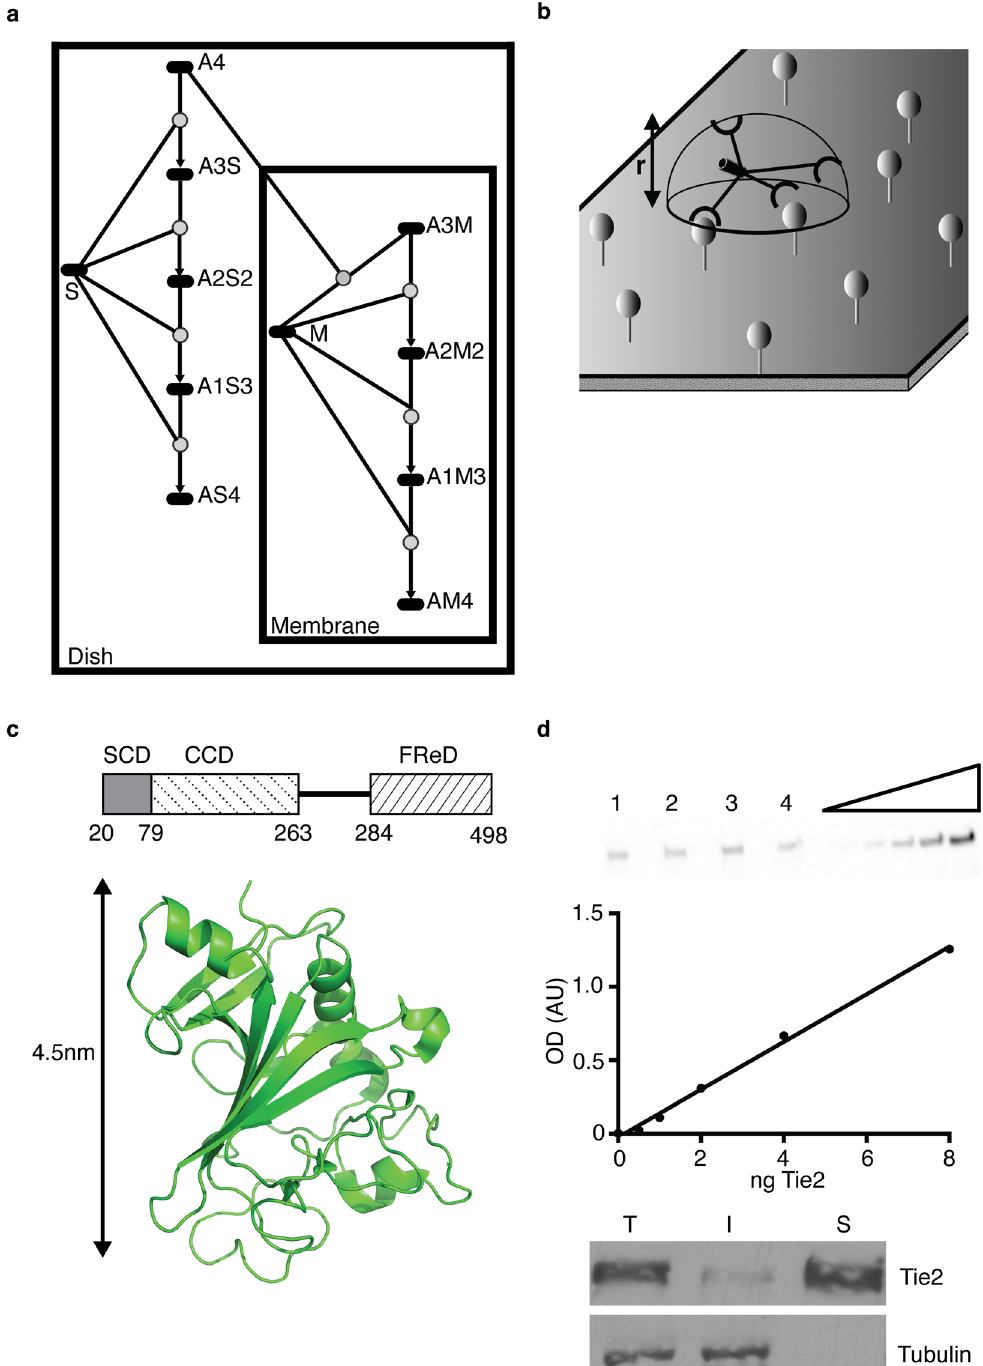
Figure 1. Mathematical model for kinetics of Ang1 binding to Tie2. ( a ) Schematic diagram of Ang1 interactions represented in Simbiology Toolbox, Matlab. A two-compartment model was constructed with Ang1 binding to sTie2 and the initial recruitment of Ang1 to cellular Tie2 occurring in the extracellular compartment. Recruitment of additional cellular Tie2 receptors occurs in the membrane compartment. Ang1 is represented by A, sTie2 by S, and cellular Tie2 by M. The suffix following A indicates the available receptor binding sites and the suffix following M and S the number of receptors bound to each tetrameric ligand. ( b ) Representation of the space in which Ang1 bound to a cell surface receptor can search for further membrane receptors. The distance above the membrane that the ligand can search is designated by r and represents the distance between binding sites on maximally extended Ang1. ( c ) Schematic representation of Ang1 showing super-clustering (SCD), coiled-coil (CCD) and fibrinogen related domain (FReD) of a monomer together with amino acid numbers at domain junctions, secretory leader domain (residues 1–19) not shown. Below: Structure of Ang1 fibrinogen related domain 39 that contains the C-terminal receptor binding domain is shown